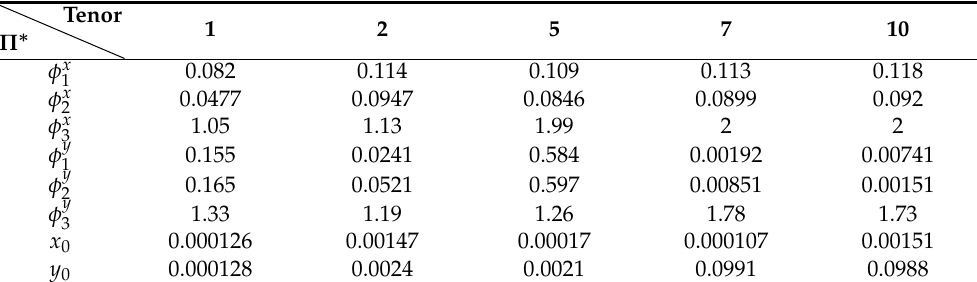
Table 2. Calibrated parameters Π ∗ using I 1 with fmincon and different swaption columns in Table A3 and corresponding strikes in Table A2 in the case of payer swaptions and maturities ranging from 5 to